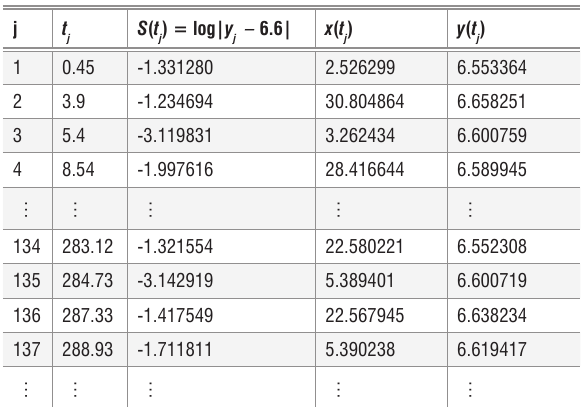
{ v } ={30.804864, 28.416644, …….22.580221, 22.567945...}, j which indicate that lim { u shows the graphs of these two sequences plotted against time.